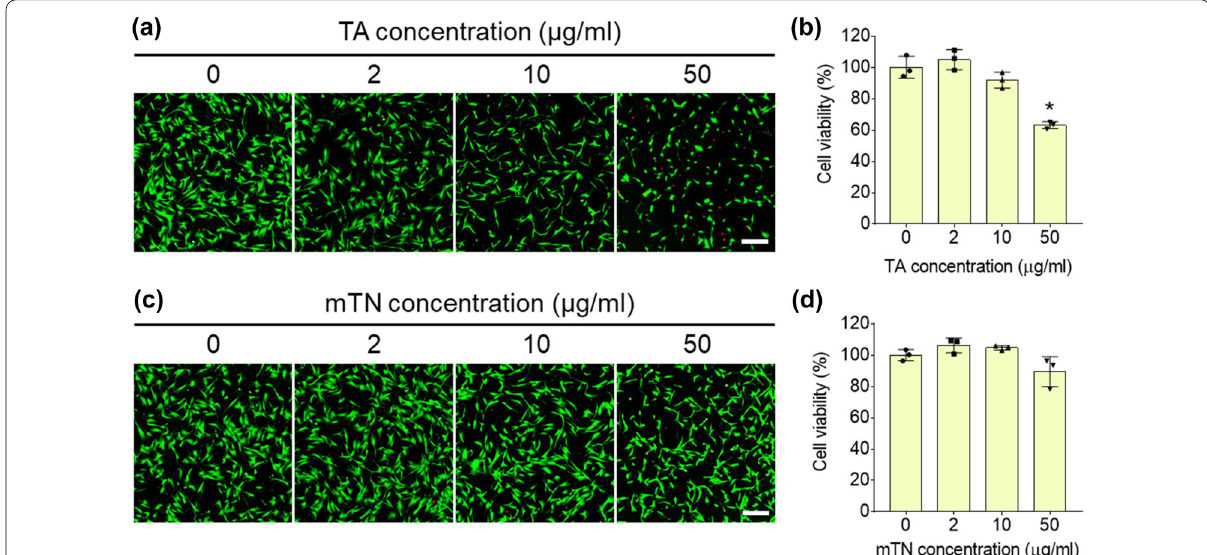
200 μm). Significantly = ∗